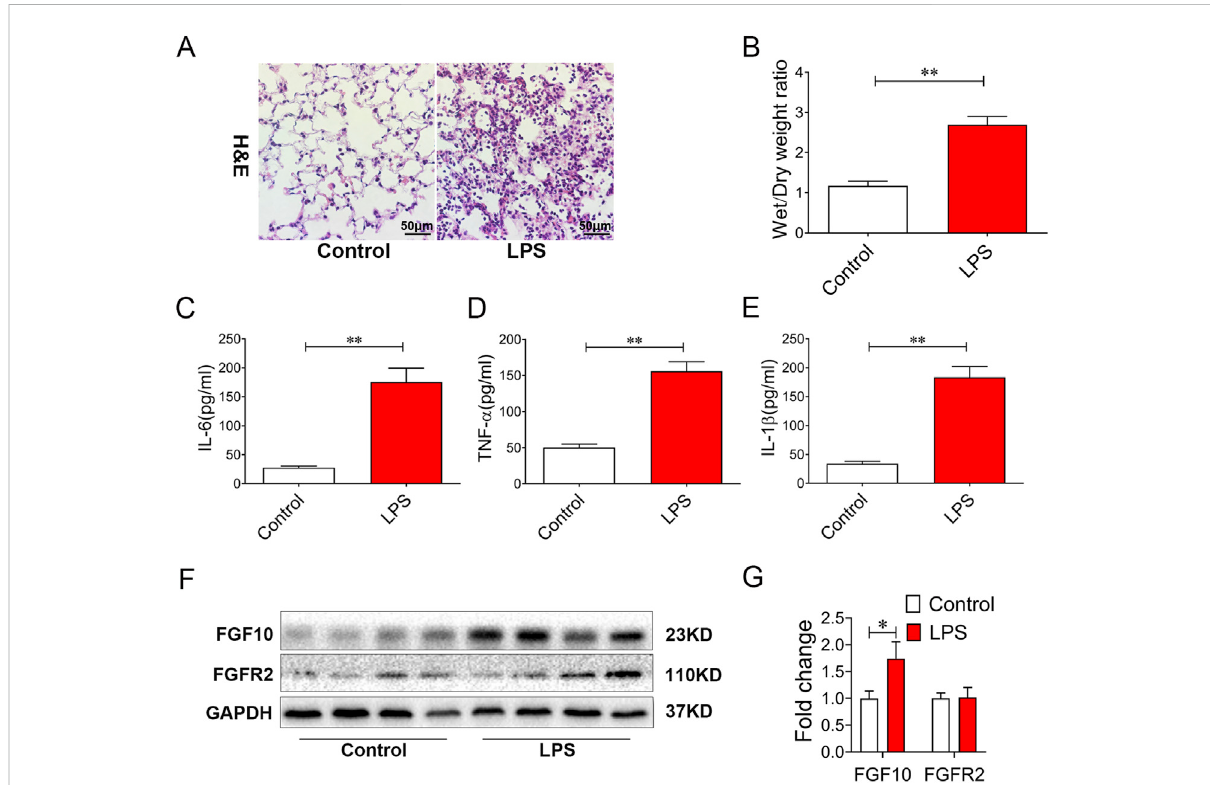
FIGURE 1 LPS treatment results in alveolar injury and increases FGF10 expression in mice. (A) Pathological change in lung tissue was detected by H&E (200×). (B) Quanti fi cation analysis of wet/dry weight ratio. (C – E) The expression of IL-6, TNF- α , and IL-1 β in BALF were determined by ELISA. (F) The expression of FGF10 and FGFR2B were detected by Western blotting. (G) Quantitative analysis of FGF10 and FGFR2B protein. The data were presented as the mean ± SEM, n = 5. * p < 0.05, * * p <